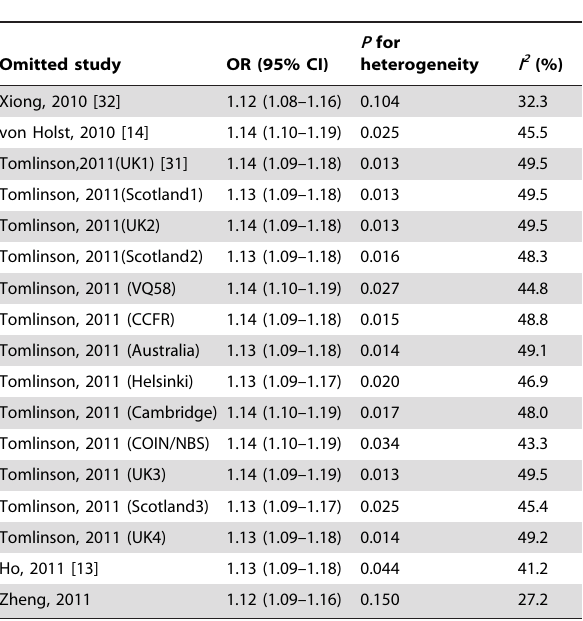
Table 4. Sensitivity analysis of additive